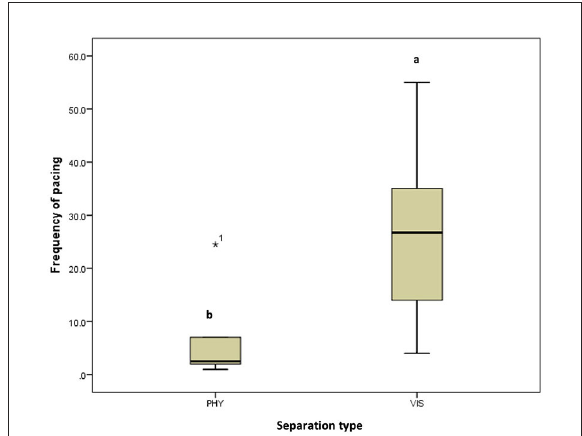
FIGURE7 Frequency of pacing of the mother hens when subjected to 10-minute physical (PHY) or visual (VIS) separation from their chicks. ab Means differ at P < 0.05.